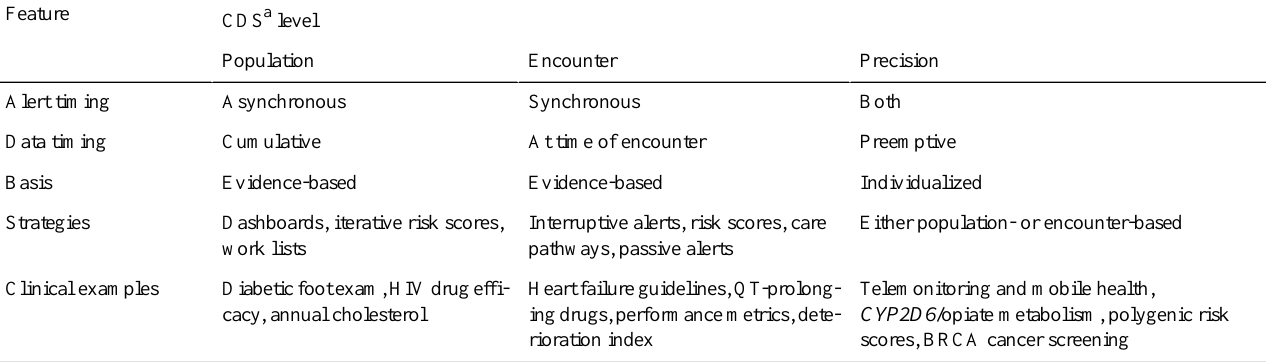
Table 1. Salient features of each domain according to each level of